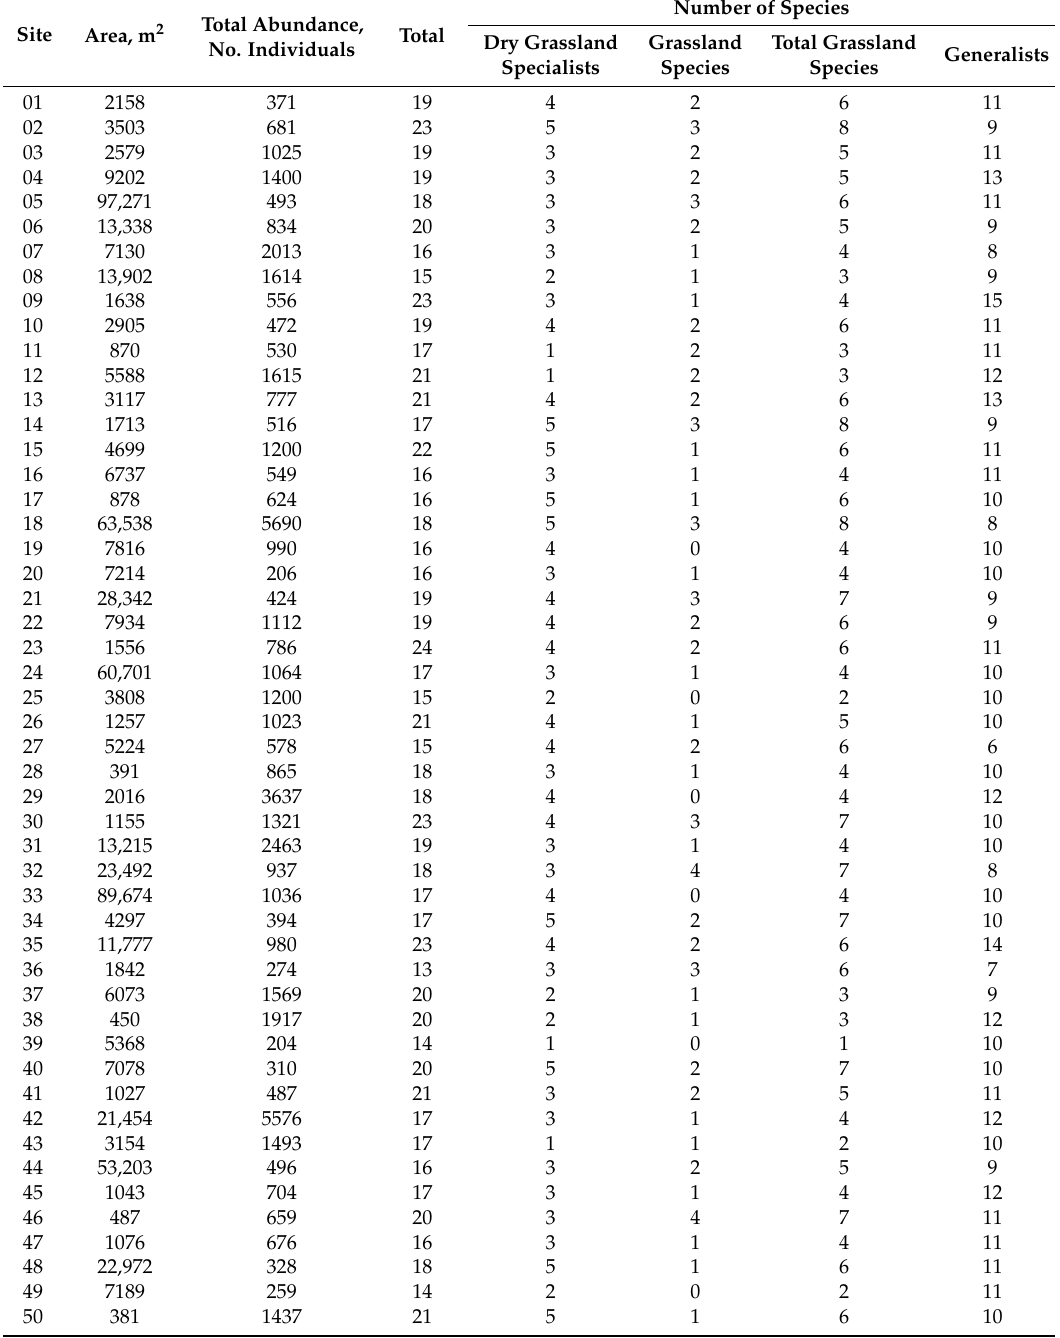
Table 2. Total abundance, no. of individuals and species richness of surface-active Collembola on 50 grassland patches in eastern